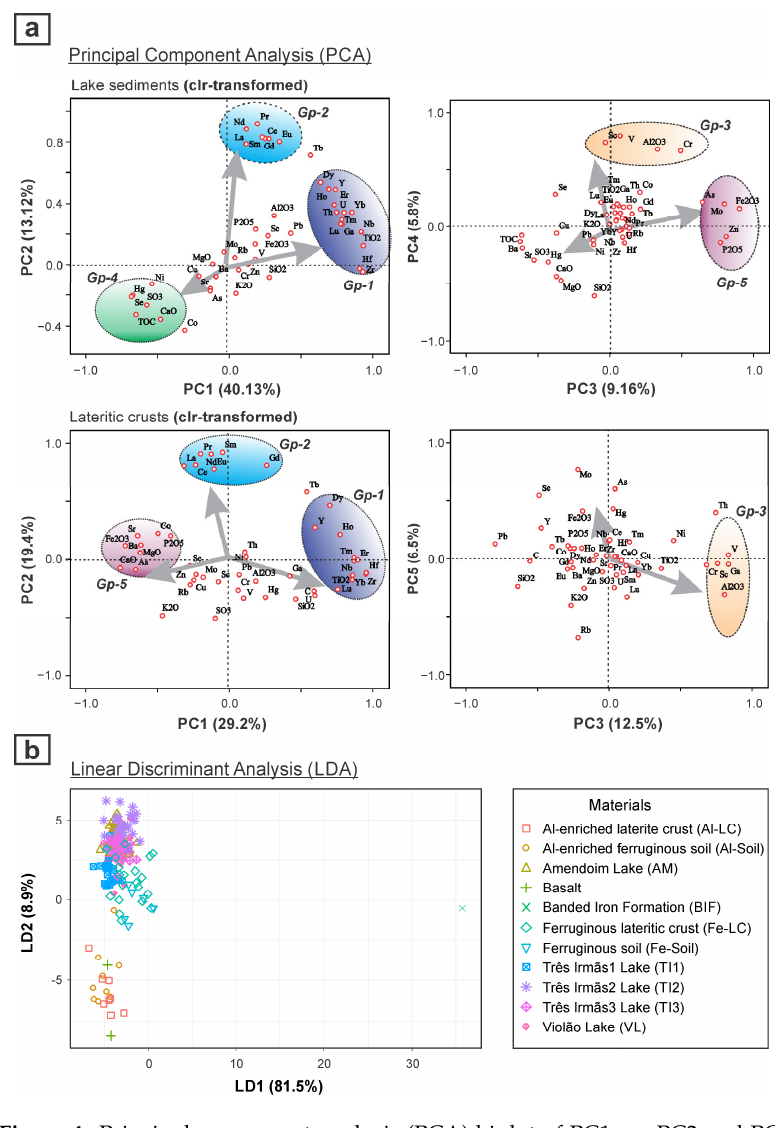
Figure 4. Principal component analysis (PCA) biplot of PC1 vs. PC2 and PC3 vs. PC4 for active lake sediments and catchment lateritic crusts [25], based on centered log-ratio (clr)-transformed data, showing the different geochemical associations and the major detrital signatures that are similar among them ( a ); and linear discriminate analysis (LDA) showing the distribution of lake sediments and the relationship with catchment basin materials ( b ).